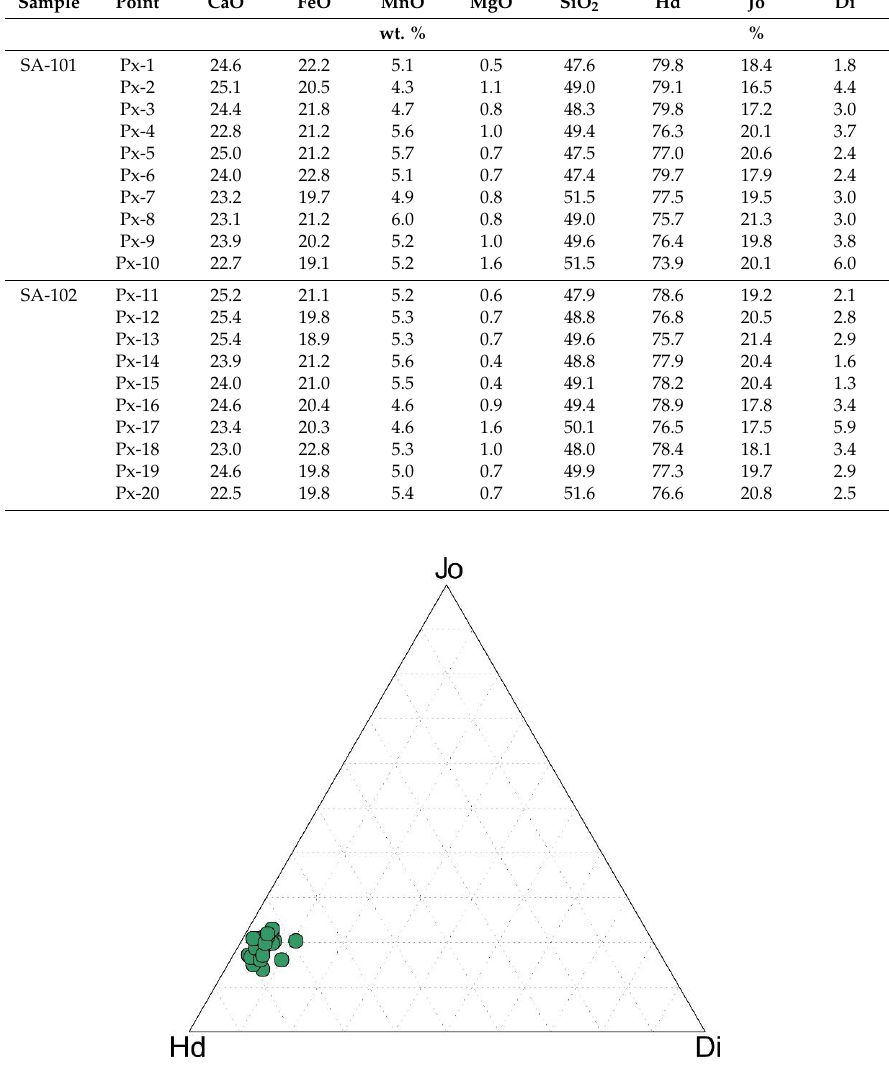
Figure 10. Jo-Di-Hd (Mn-Mg-Fe) ternary diagram showing compositional variations of pyroxenes from the Sasa Pb-Zn-Ag skarn deposit. End members are Di = diopside, Hd = hedenbergite, and Jo = johannsenite. Table 2. Semi-quantitative composition of sulfides from the Sasa Pb-Zn-Ag skarn deposit. n — number of point analyses per sample; <d.l. — below detection limit; STD — standard deviation.